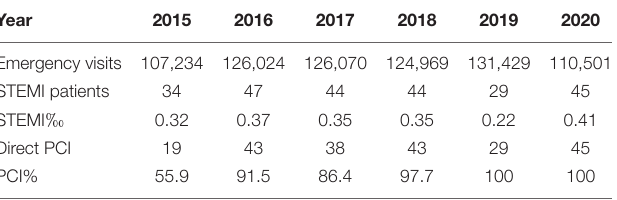
TABLE 2 | Comparison of age, gender and history between two groups.